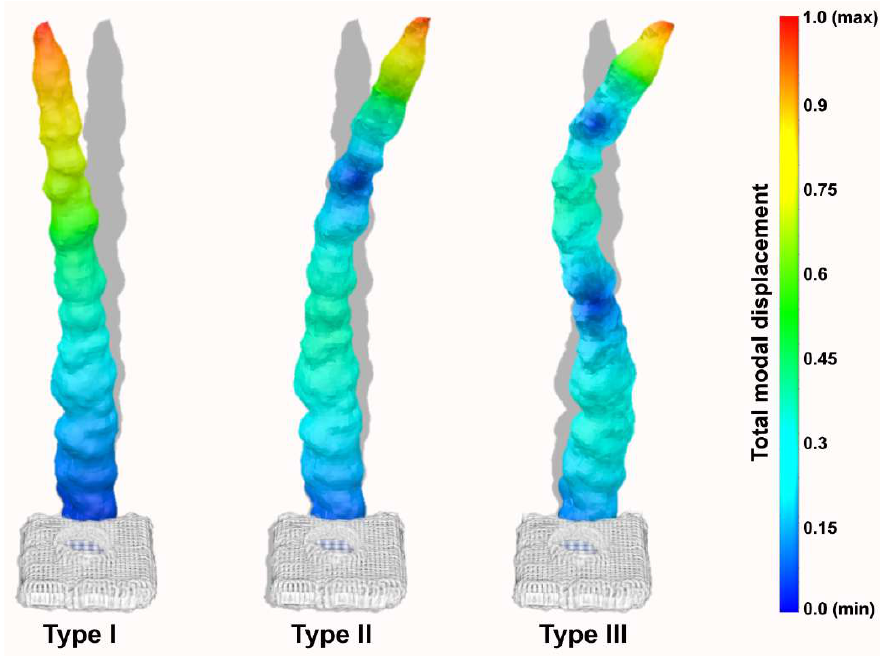
Figure 9. First three types of modes shape of the Minaret stalagmite; the total modal displacement is color-coded, modeled with Autodesk Fusion 360. Table 3. Results of the FEM modal analysis based on the 3D-scan model of the Minaret